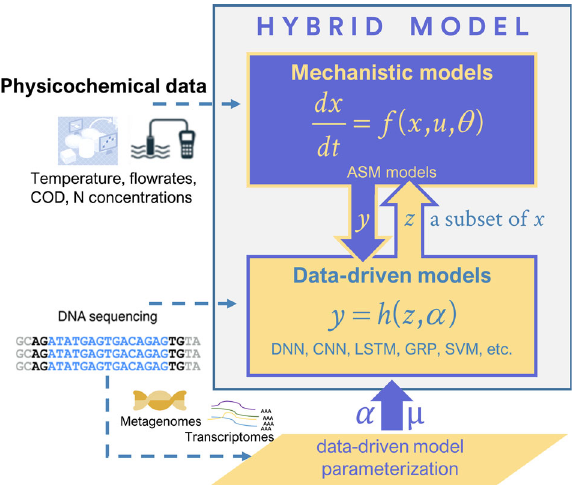
Fig. 4 Integration of physicochemical and molecular sequence data in hybrid modeling. A proposal to integrate explicitly biological data in process